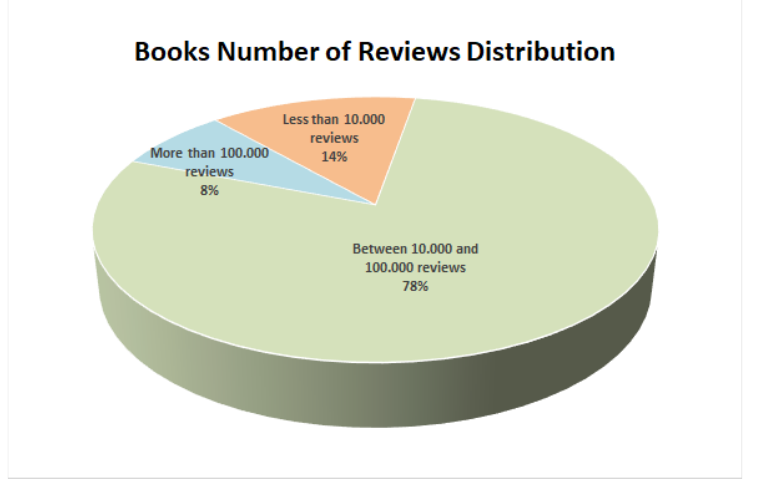
Figure 3. Books classification considering the number of reviews available on Goodreads website.